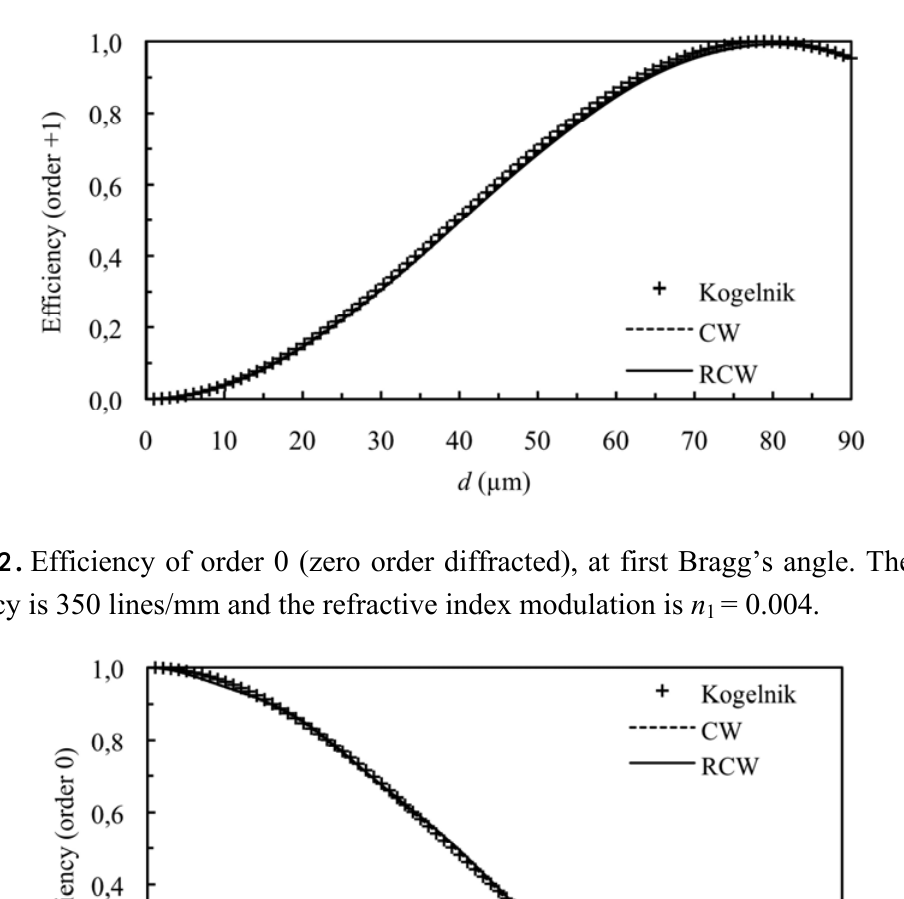
Figure 1. Diffraction efficiency of order +1 (first order diffracted), at first Bragg’s angle. The spatial frequency is 350 lines/mm and the refractive index modulation is n